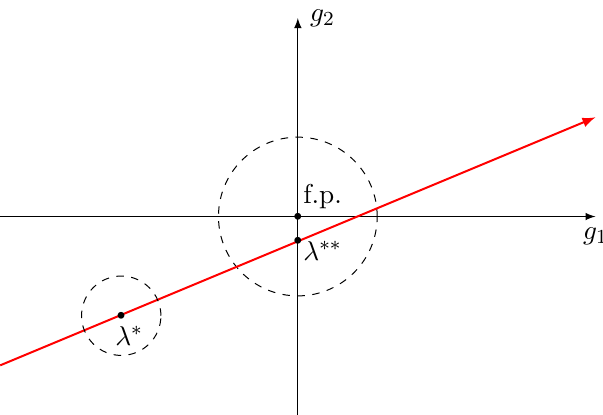
Figure 1. A sample TCSA trajectory in f g i g -space. Two perturbative regimes are marked by